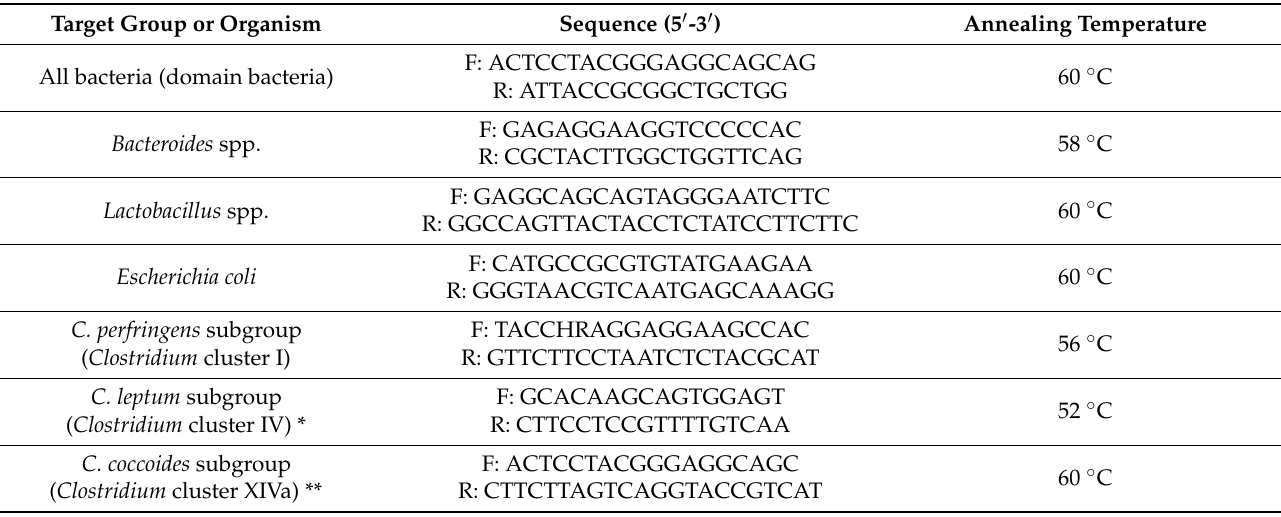
Table 2. Primer sequences, targeting the 16S rRNA gene for the detection and quantitation of bacteria (according to Mountzouris et al. [29]).